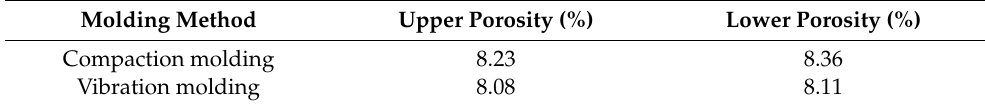
Table 5. Porosity difference between upper and lower parts of